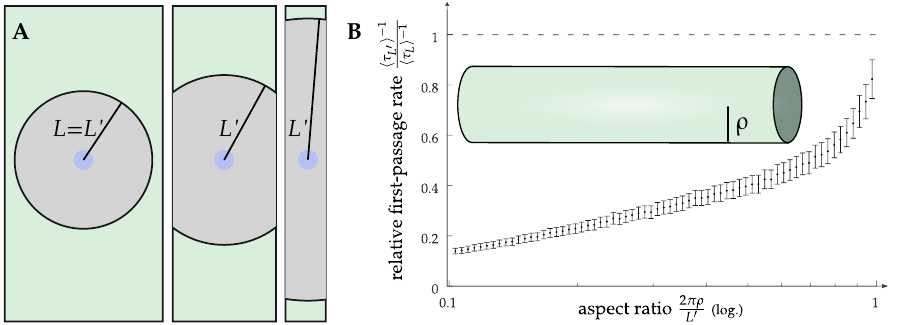
Figure 5. ( A ) Sketch of the change in the Doi model geometry on a cylinder for varying cylinder radii (cylinder is also sketched as an inset of ( B )). We compare models of the same interaction area π L 2 . Due to the periodic boundary conditions, this leads to a larger extension in the axial